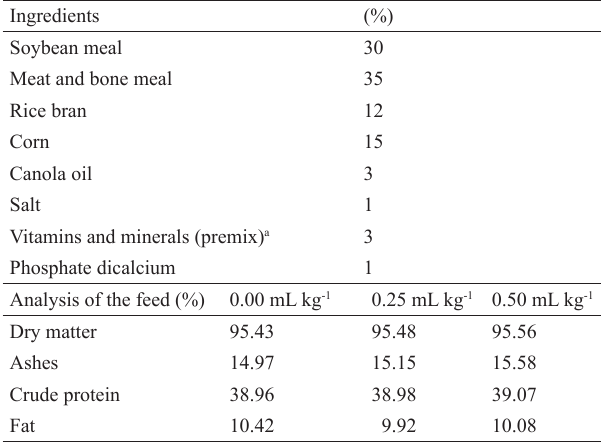
Table 1. Formulation of the experimental diets. a Vitamin and mineral mixture (security levels per kilogram of product)- folic acid: 250 mg, pantothenic acid: 5000 mg,